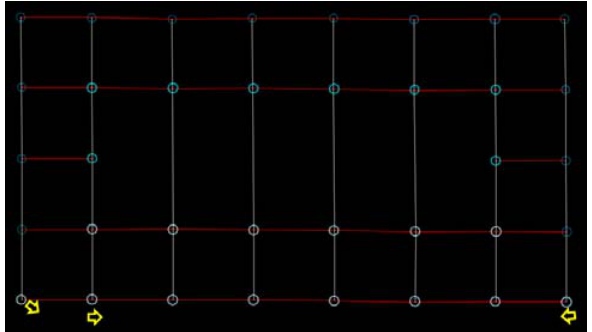
Fig.6 The positions of the column with abnormal